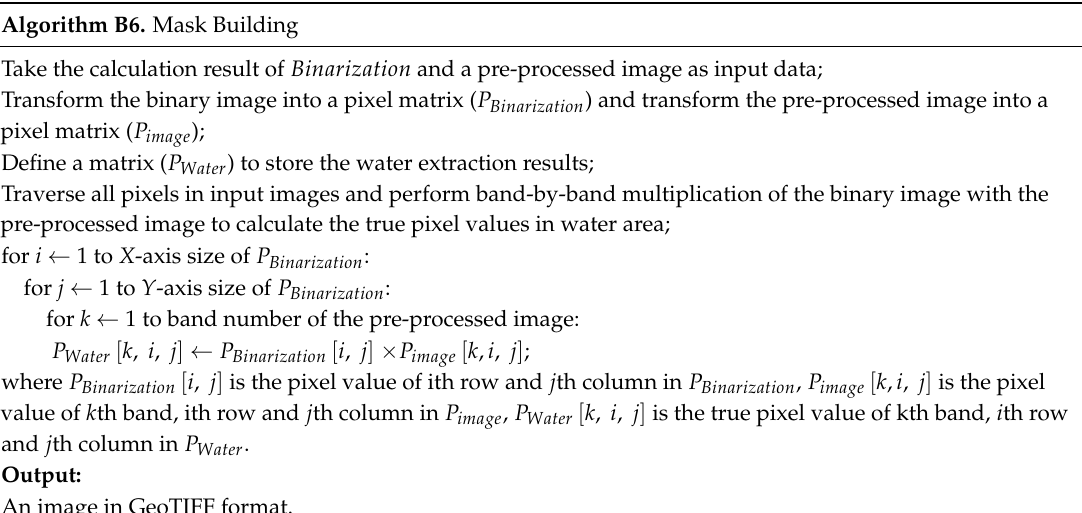
Algorithm B6. Mask Building